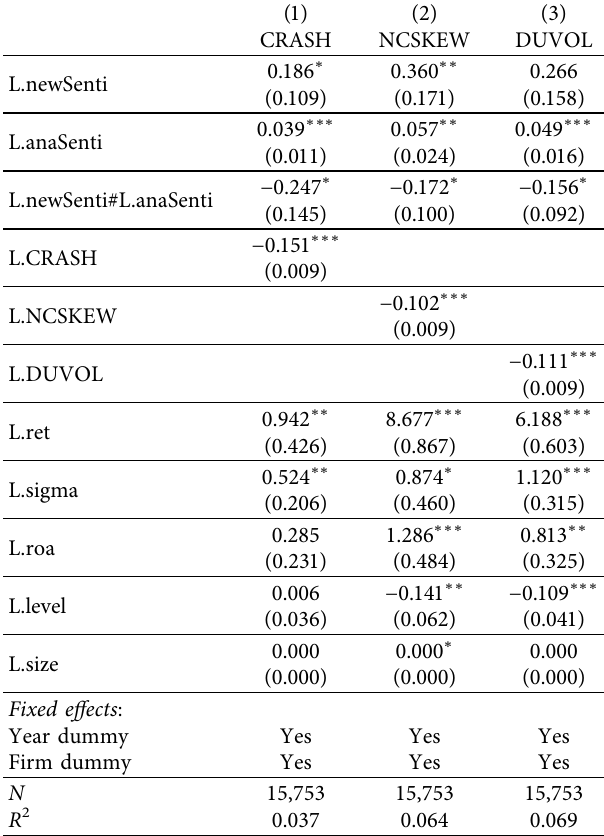
Table 13: Regression of adding analyst and media coverage sen- timent